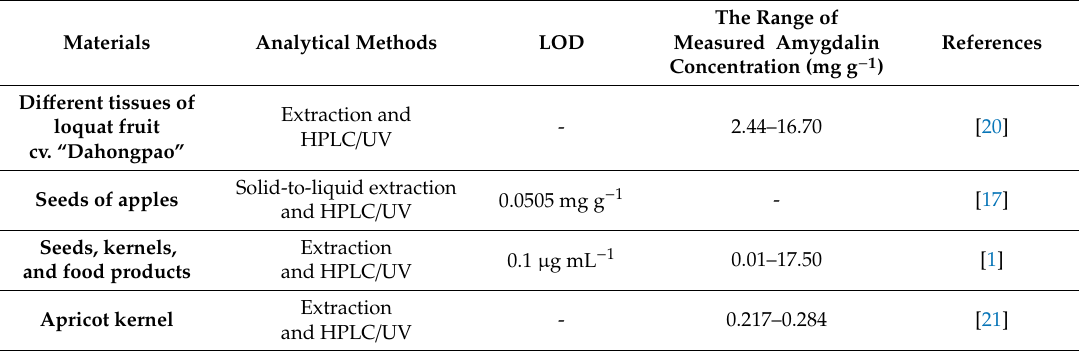
Table 1. Analytical methods used in the analysis of amygdalin in a deferent